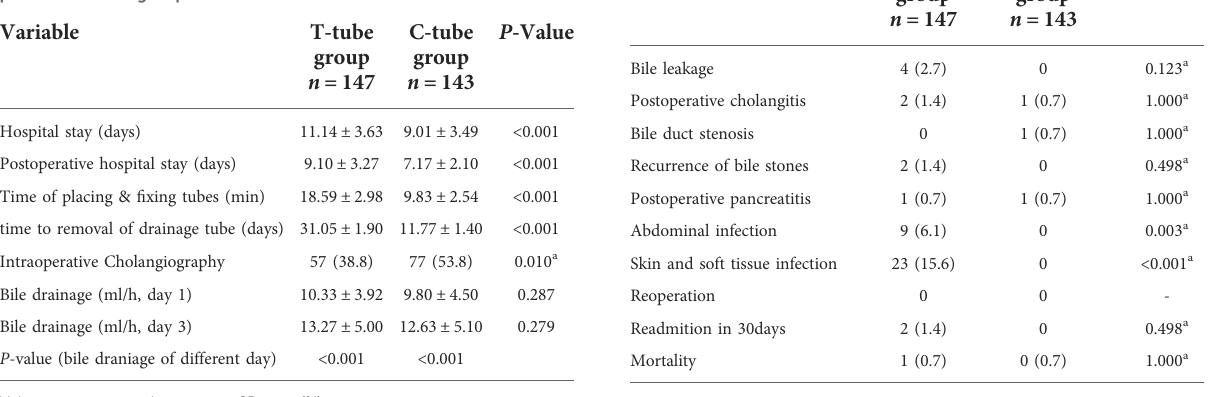
TABLE 2 Surgery-related conditions and postoperative outcomes of patients in each group.